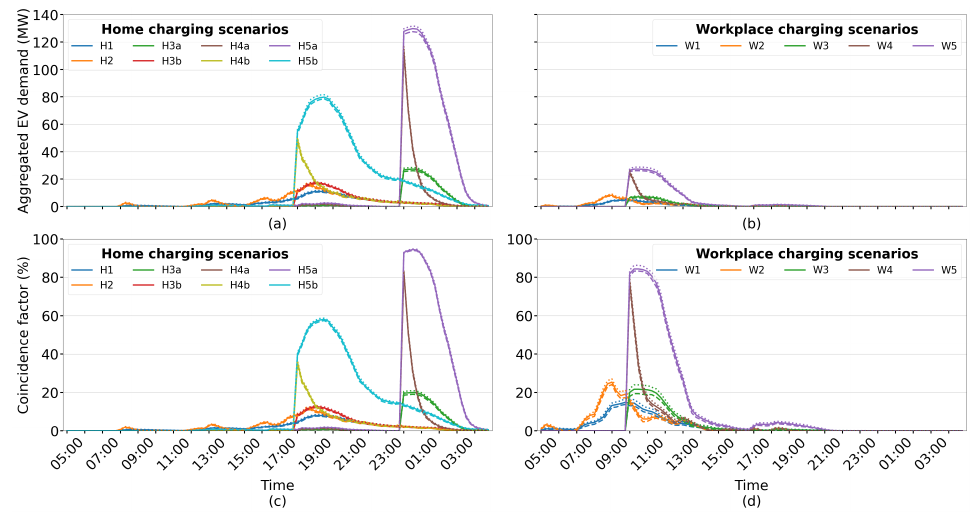
Figure 6. EV demand simulation results. The aggregated EV demand over 24 h is illustrated for ( a ) home and ( b ) workplace charging scenarios. Furthermore, the concomitant coincidence factor is illustrated for ( c ) home and ( d ) workplace charging scenarios. Average, minimum and maximum values for the 40 demand profiles are illustrated by solid, dashed and dotted lines, respectively.